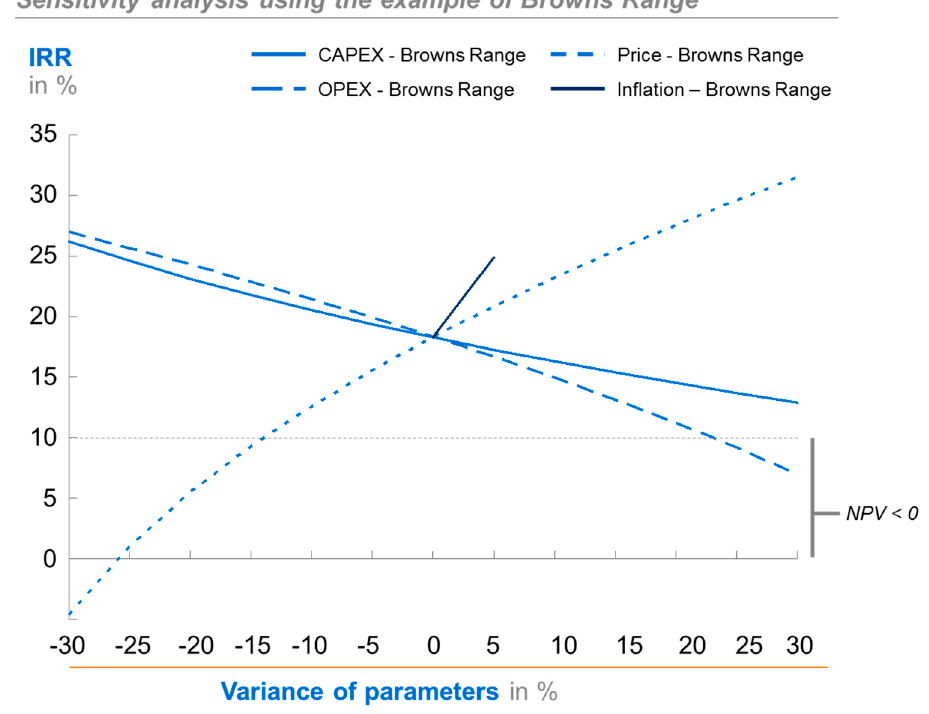
Figure 10. Sensitivity analyses for the parameters of Capex, Opex, and the basket price of the project Browns Range.